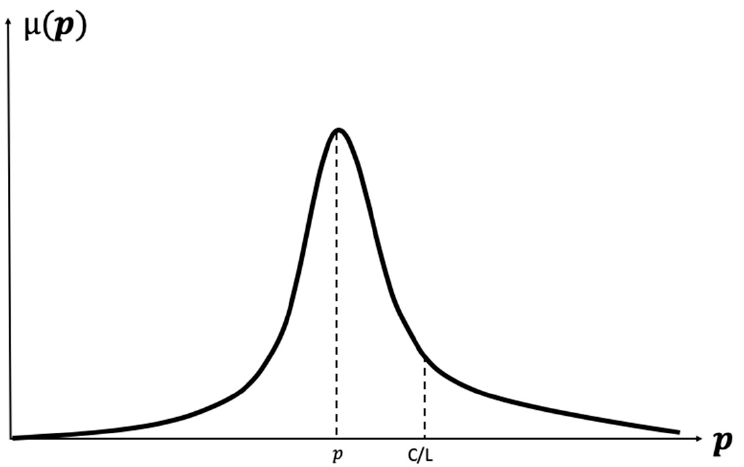
Figure 2. Cost–loss model in the presence of ambiguity. Source: own elaboration from Allen and Eckel [35].